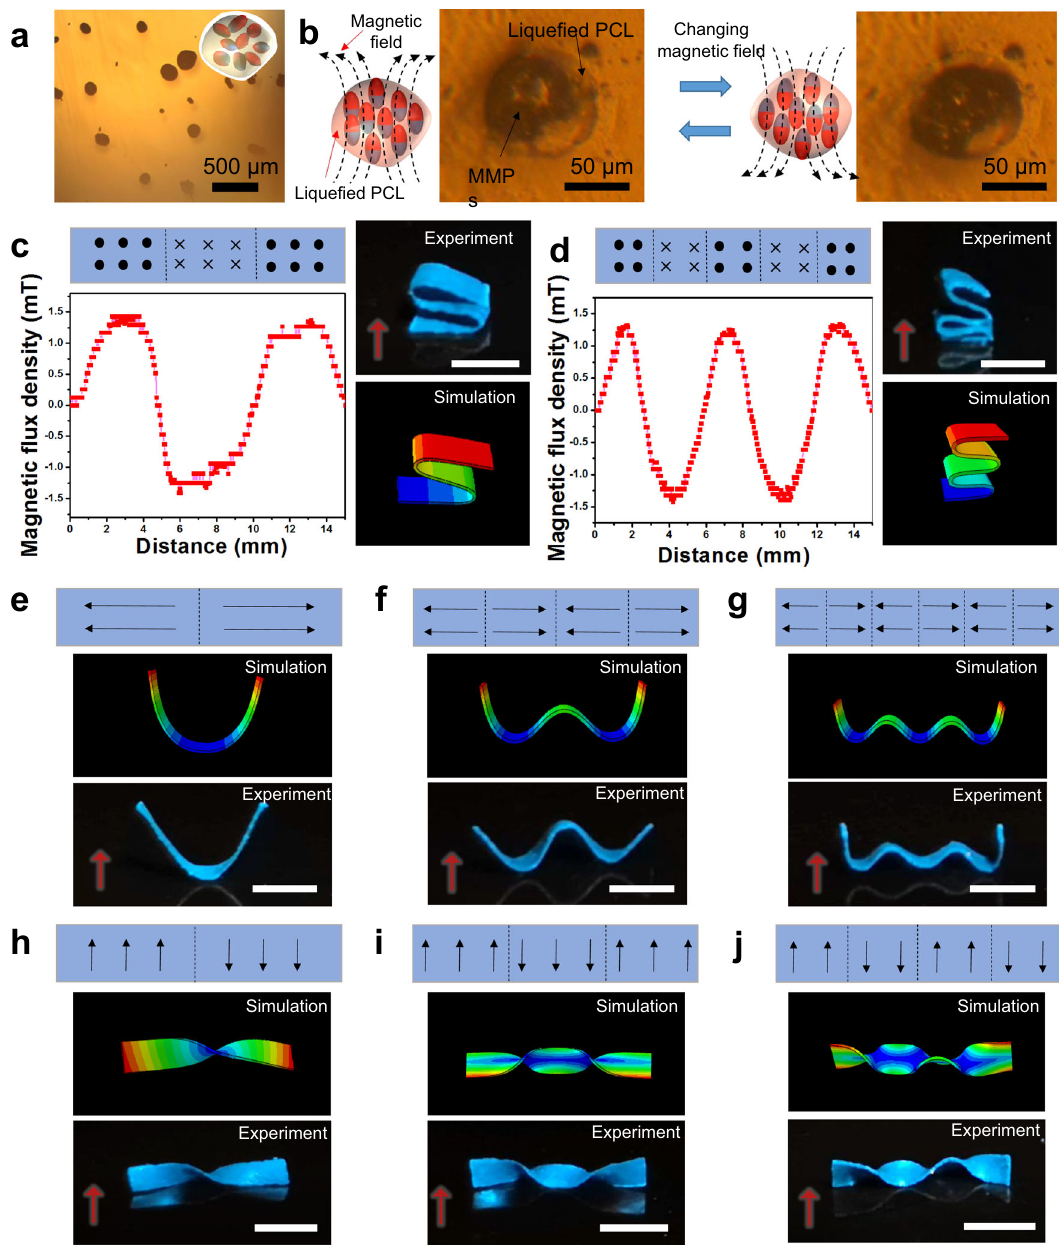
Fig. 2 Mechanism study on programming and reprogramming magnetic anisotropies in MRSM fi lms. a An optical image of NdFeB@PCL MPs. b Schematic and optical images showing reorientation of NdFeB MPs in NdFeB@PCL MPs by an external magnetic fi eld when heated above the